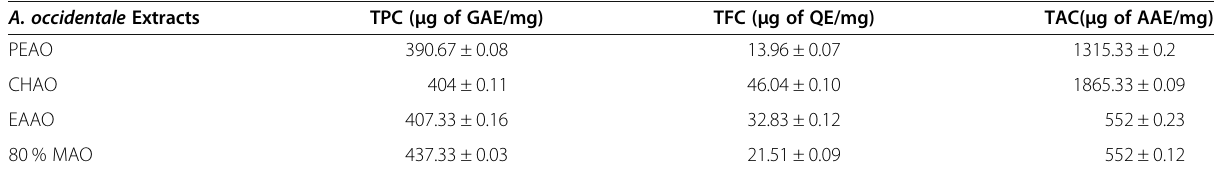
Table 2 Amount of total phenolic and flavonoid contents and total antioxidant capacity of Petroleum ether, Chloroform, Ethyl acetate, and 80 % Methanolic Extracts of A. occidentale roots A. occidentale Extracts